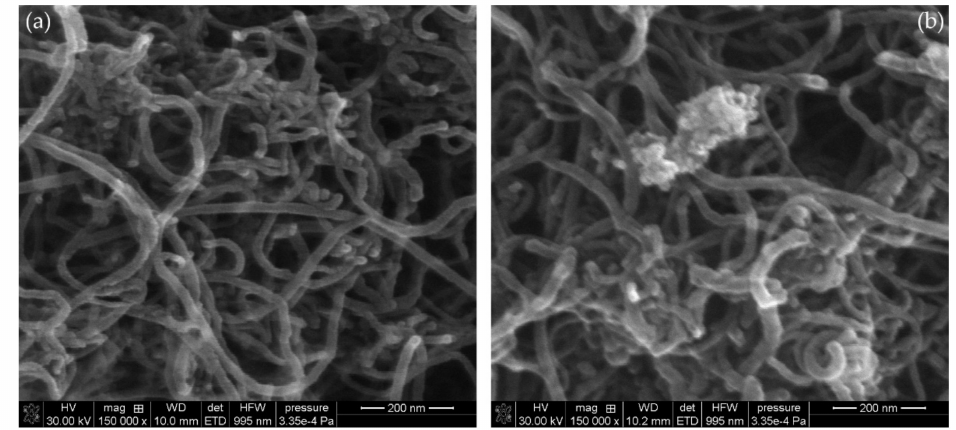
Figure 9. SEM images of MWCNTs: nonmodified ( a ) and modified with PDMS ( b